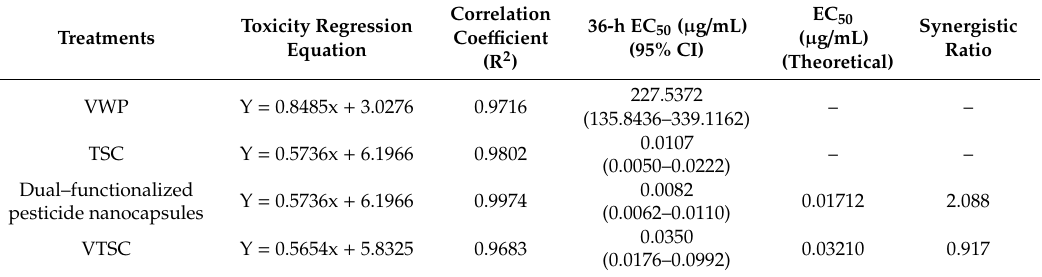
Table 2. Bioactivity of the dual-functionalized pesticide nanocapsules against Rhizoctonia solani.